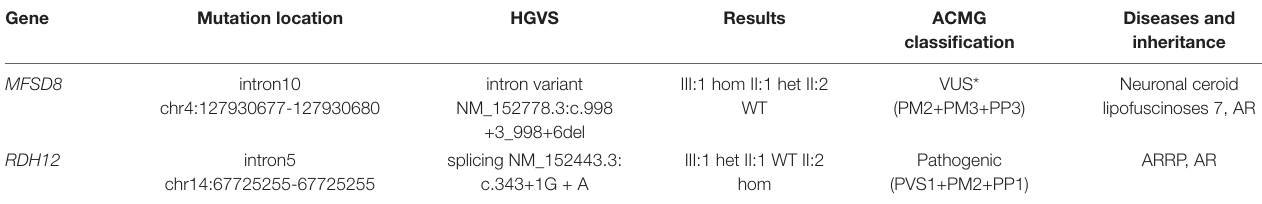
TABLE 1 | The result of WES.